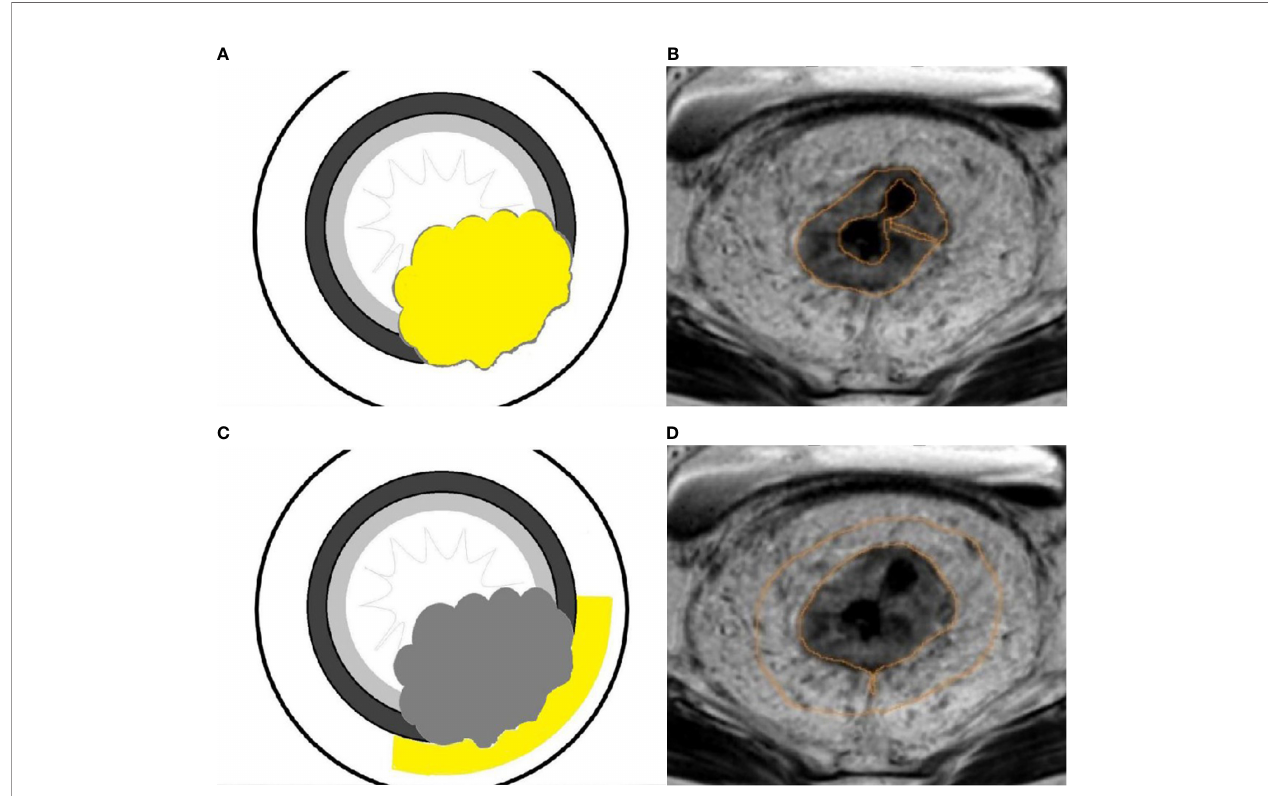
FIGURE 3 | A schematic diagram of ROI delineation for rectal carcinoma (A) ; Target delineation in rectal carcinoma on the SyMRI image (B) ; A schematic diagram of ROI delineation for pararectal fat space (C) ; Target delineation in the pararectal fat space on SyMRI image (D)